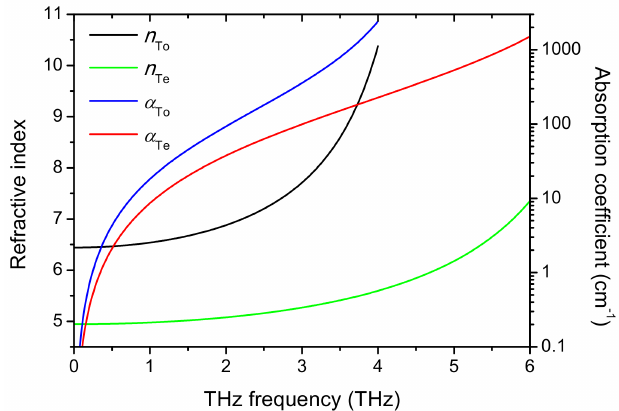
Figure 2. The dispersion and absorption characteristics of the two orthogonally polarized THz waves, THz e and THz o . n Te and n To are the refractive indices of THz e and THz o , respectively, and α Te and α To are the absorption coefficient of THz e and THz o ,